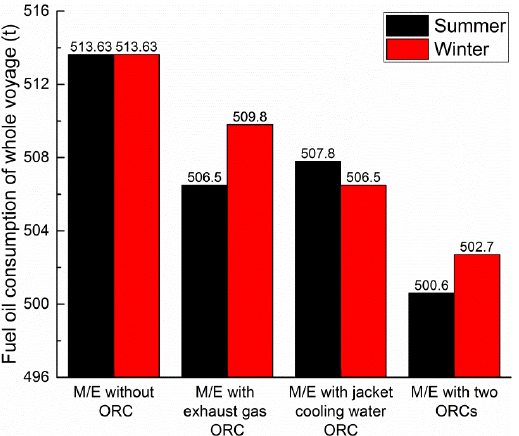
Figure 7. Fuel oil consumption of the whole voyage when adopting high ‐ sulfur fuel oil. The energy saving data of the ORC system at different stages or events of the whole voyage when the ship adopted low ‐ sulfur fuel oil are exhibited in Tables 12 and 13 and Figure 8. When the ship sailed in summer, the total work or amount of energy saving produced by the ORC subsystem on the exhaust gas side and that on jacket cooling water side during the whole voyage was 78,515.4 kWh and 27,522 kWh, respectively. In winter, the total work produced or amount of energy saving by the subsystem on exhaust gas side and that on jacket cooling water side was 71,096.2 kWh and 34,370.7 kWh, respec ‐ tively.